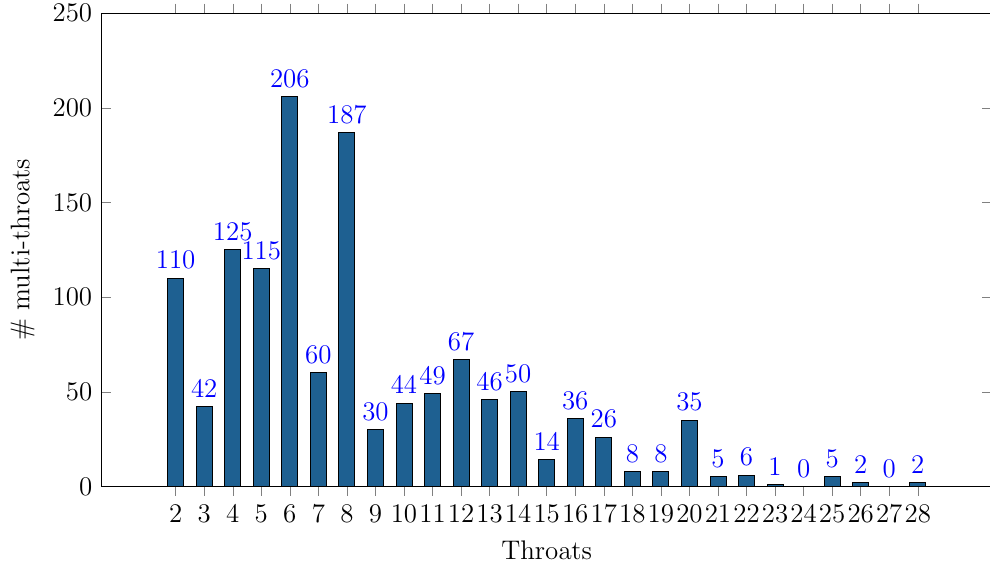
Figure 6 . Number of multi-throats in M 2 that admit from 2 to 28